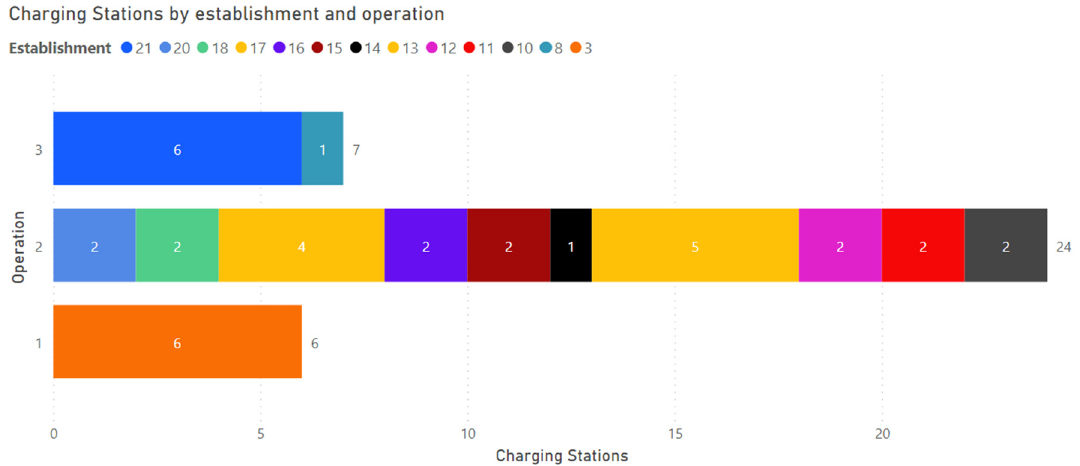
Figure 7. Charging stations by establishment and operation.